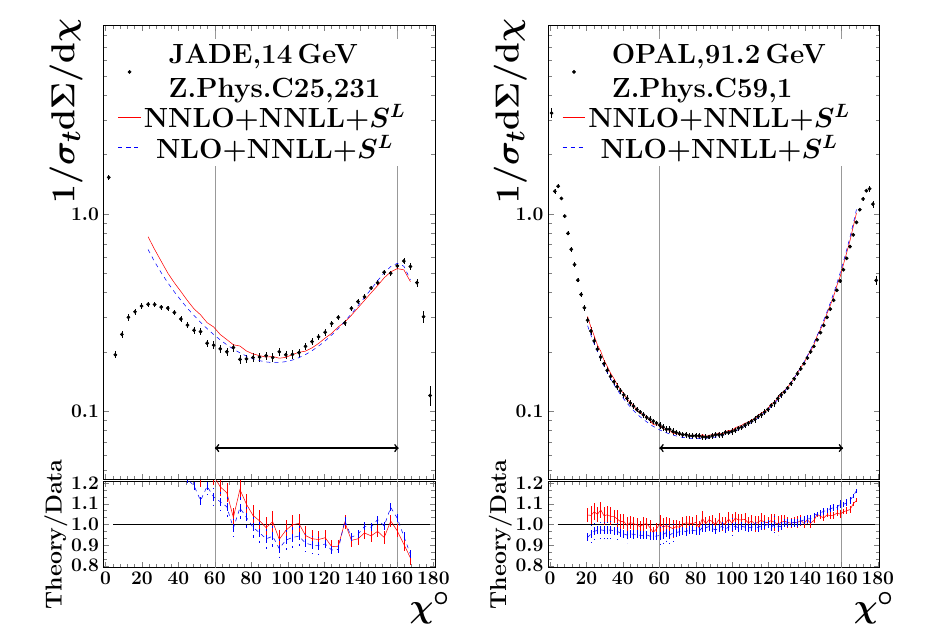
Figure 2. (left) The figure shows the data for the EEC from JADE at 14 GeV together with the results of the default fit (solid red line) and the NLO + NNLL fit (dashed blue line). The lower plot presents the ratio of the theory prediction and the data. (right) Same as for (left) but with data from OPAL at 91.2